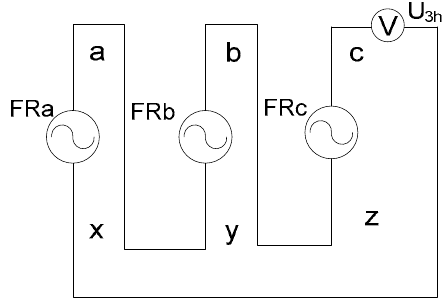
Figure 8. Wiring diagram with zero sequence path.